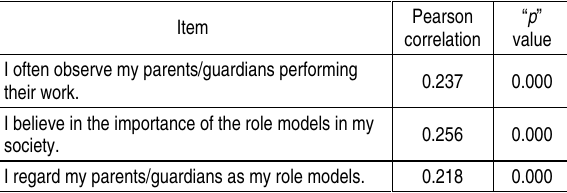
Table 5. Correlation between parents’ work and